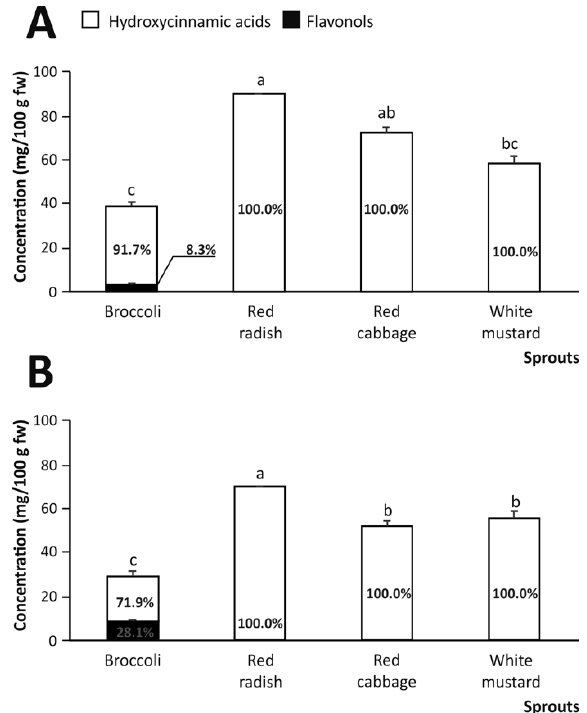
Figure 4. The total content of phenolic compounds (mg/100 g fw) in the fractions of the gastric ( A ) and intestinal ( B ) digestion processes of cruciferous sprouts with the indication of the percentage of flavonols and hydroxycinnamic acids contributing to the (poly)phenolic composition. Mean values ± SD (n = 3) with different lowercase letters are significantly different at p < 0.01 according to the analysis of variance (ANOVA) and Tukey’s multiple range test.